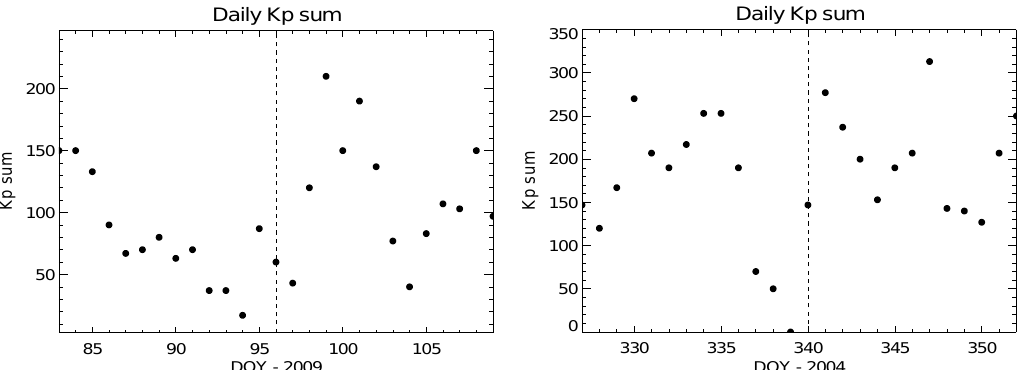
Fig. 2. Variation of the daily sum Kp-index 10days before and after seismic events which occurred on 6 April 2009 (left panel) and 5 December 2004 (right panel). The EQ dates are indicated by dashed vertical lines.